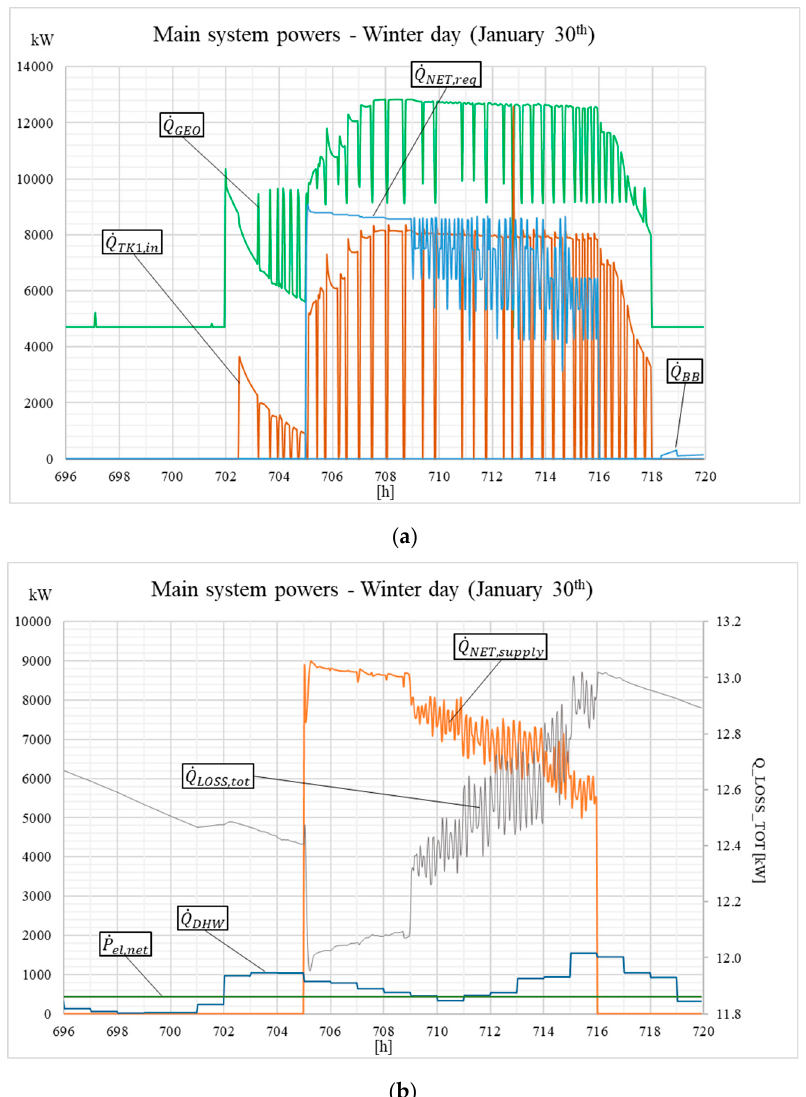
. . . . . Q geo , Q NET.req, Q TK1,in and Q BB ( a ); Q DHW ,